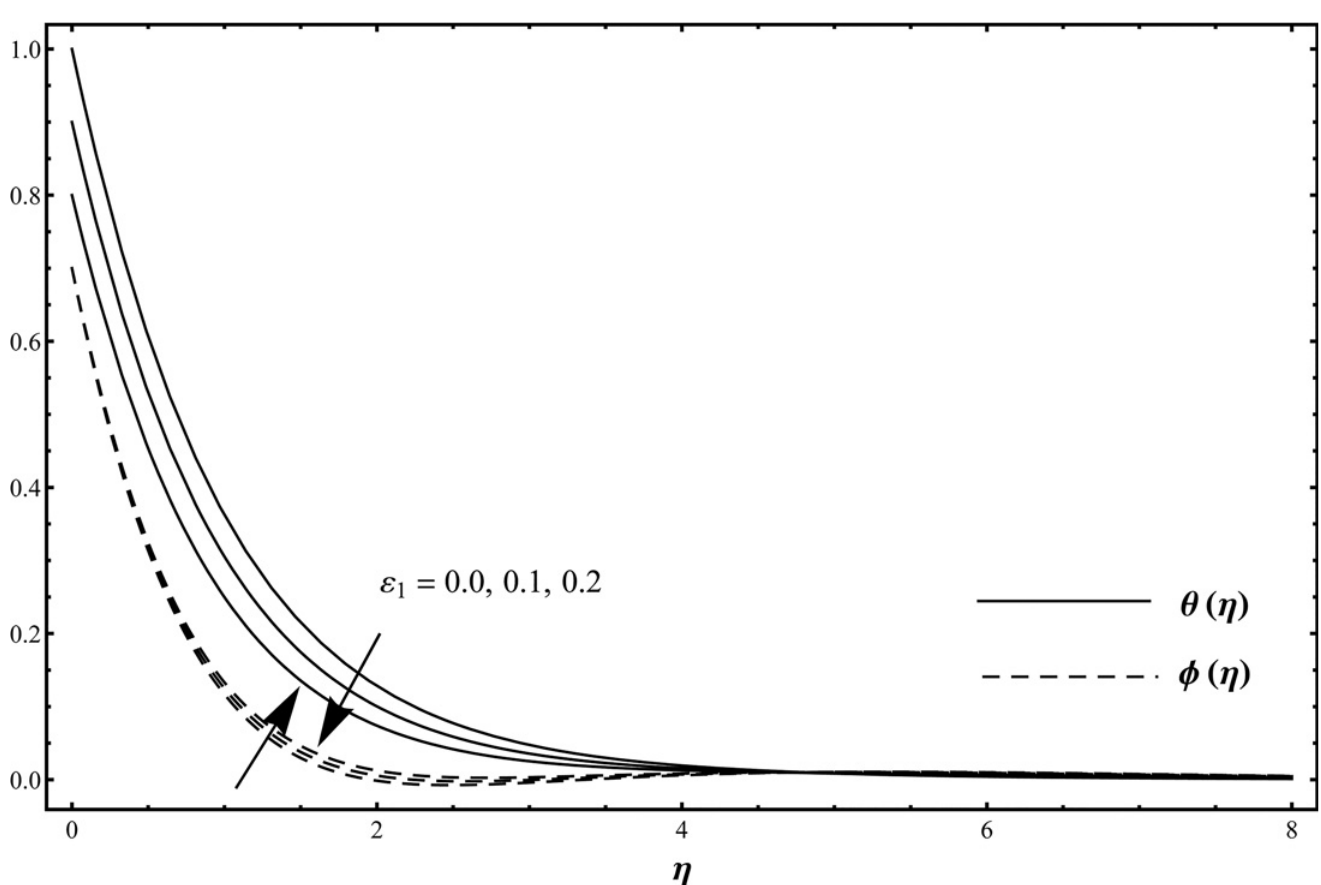
Fig 4. Temperature distribution function θ ( η ) and concentration distribution function ϕ ( η ) when ε 1 = 0.0, 0.1, 0.2 and β 1 = β 2 = 0.2 = γ = Rd , λ = 0.1 = N , Pr = 1.0 = Sc , ε 2 =